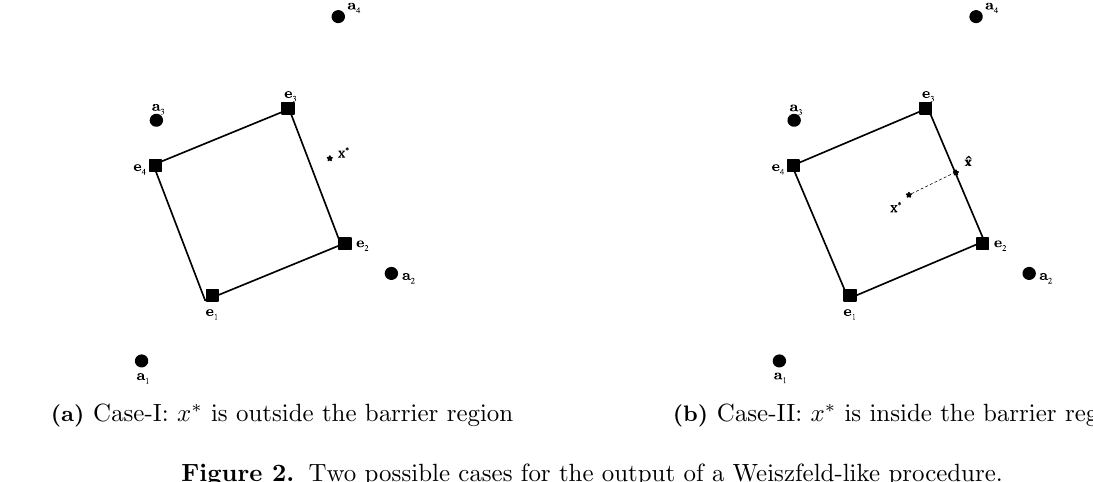
Figure 2. Two possible cases for the output of a Weiszfeld-like